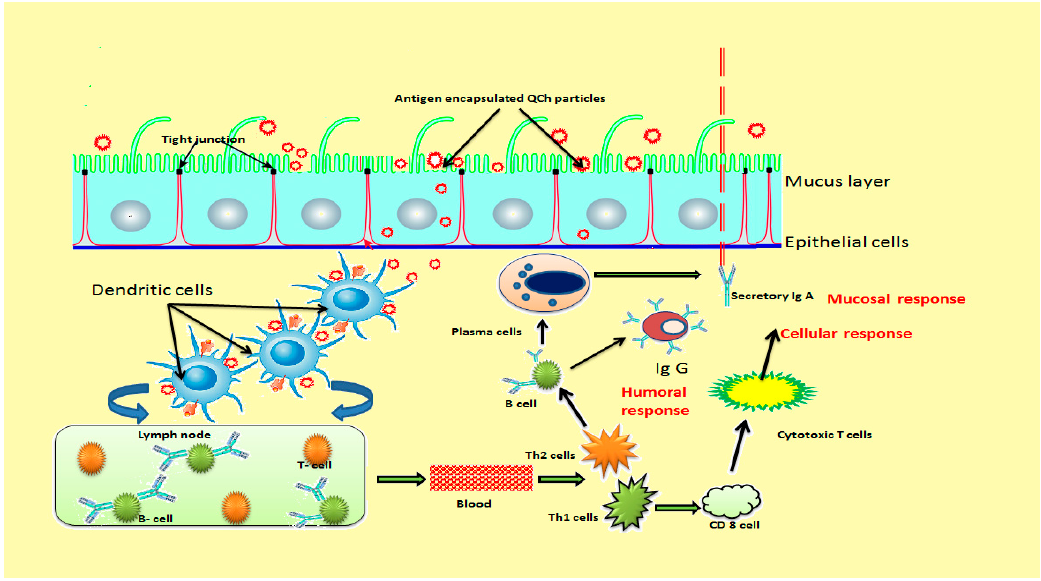
Figure 10. Schematic illustration of immunity development after administration of mucoadhesive QCh-based vaccine adjuvant.